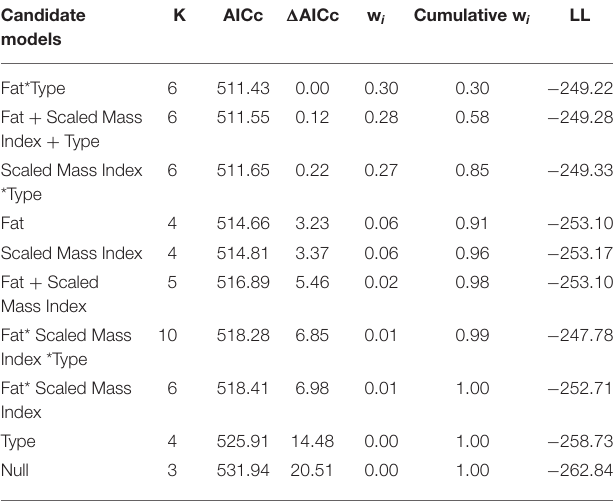
TABLE 2A | Model selection table for ten candidate models for Vocal Deviation ∼ Body Condition.